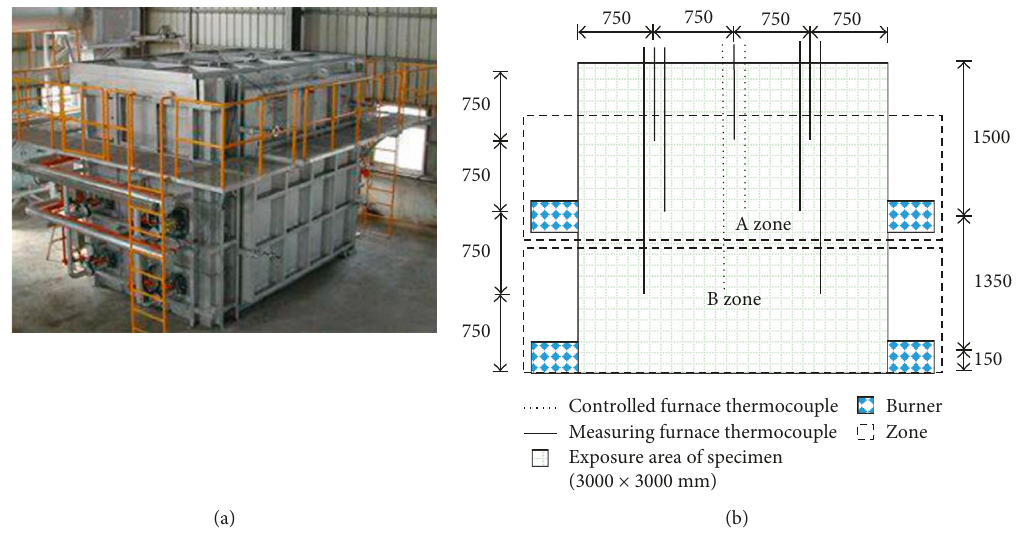
Figure 1: Full-size high-temperature furnace (inner size: 300cm in width, 300cm in height, and 240cm in depth).